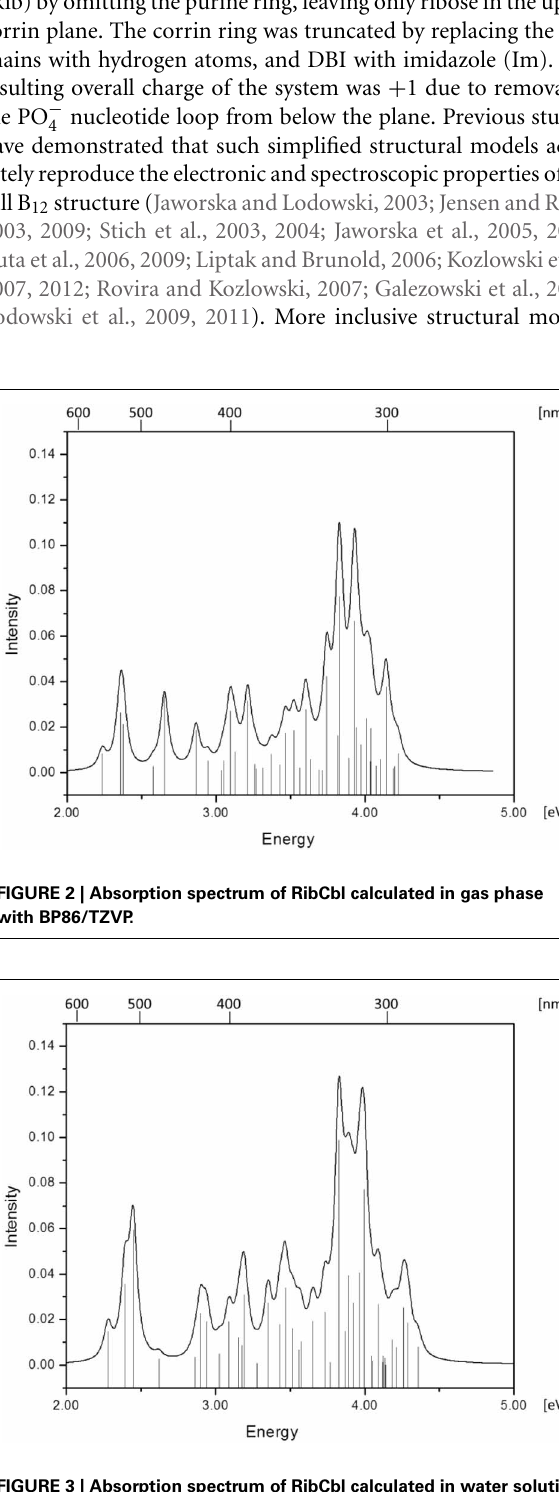
FIGURE 3 | Absorption spectrum of RibCbl calculated in water solution with